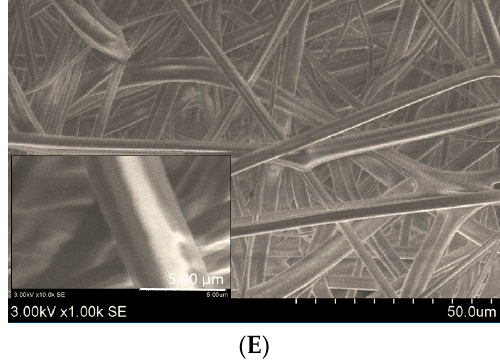
Figure 1. SEM images of electrospun EE100 in OEE mats at various EE100 contents (%): ( A ) E-8; ( B ) E-16; ( C ) E-24; ( D ) E-32; ( E ) E-40. Magnification: 1000 × , scale bar: 50 µm, and magnification: 10,000 × , scale bar: 5 µm.